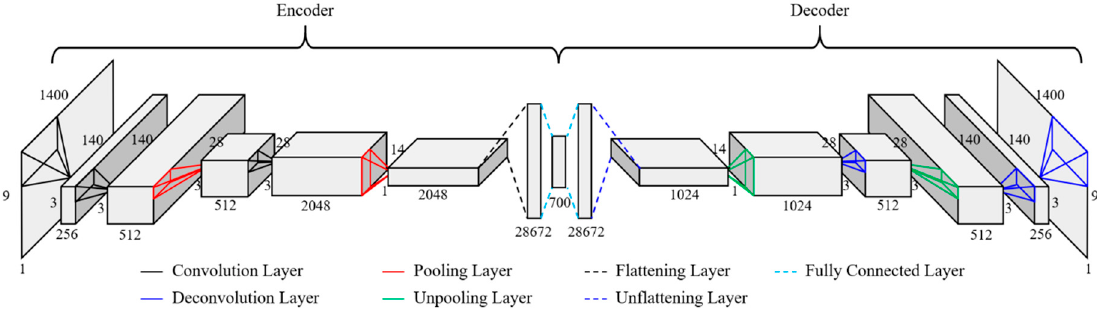
Figure 9. CAE architecture for multi ‐ vehicle traffic loads.